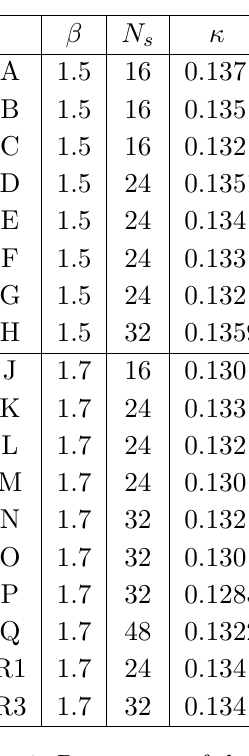
Table 1 . Parameters of the simulation